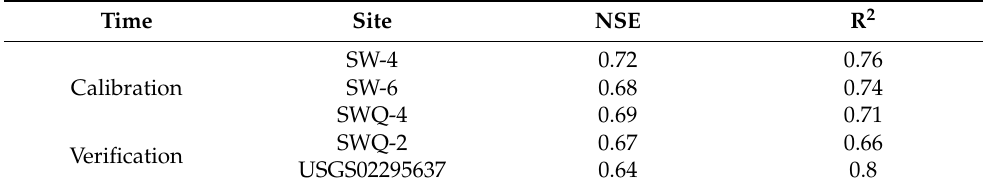
Table 9. Evaluation indexes of the daily runoff simulation results of the five